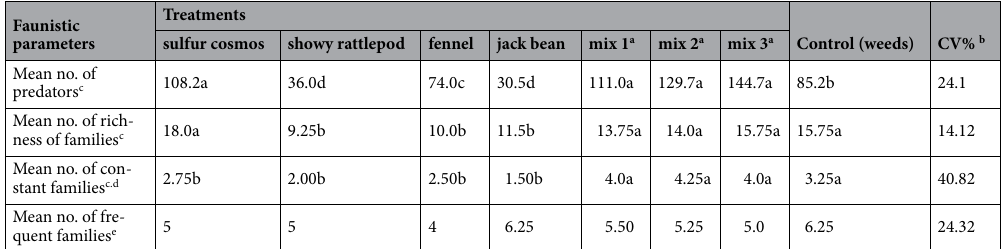
Table 2. Faunistic parameters of predatory arthropods captured in plants under single-cropping and mixes. Seropédica, RJ, Brazil, July to November 2017. a Mix 1, 2, and 3 represent the intercropping of sulfur cosmos, showy rattlepod, fennel, and jack bean in three cultivation densities 10.8, 14.3, and 21.5 plants m −2 , respectively; b CV = Coefficient of variation; c Means followed by the same letter on the line do not statistically differ by the Scott-Knott test (p < 0.05); d Presence higher than 50% in samples; e Frequency higher than the upper confidence interval (p < 0.05), which indicates that do not differ from each other by the F test (p <